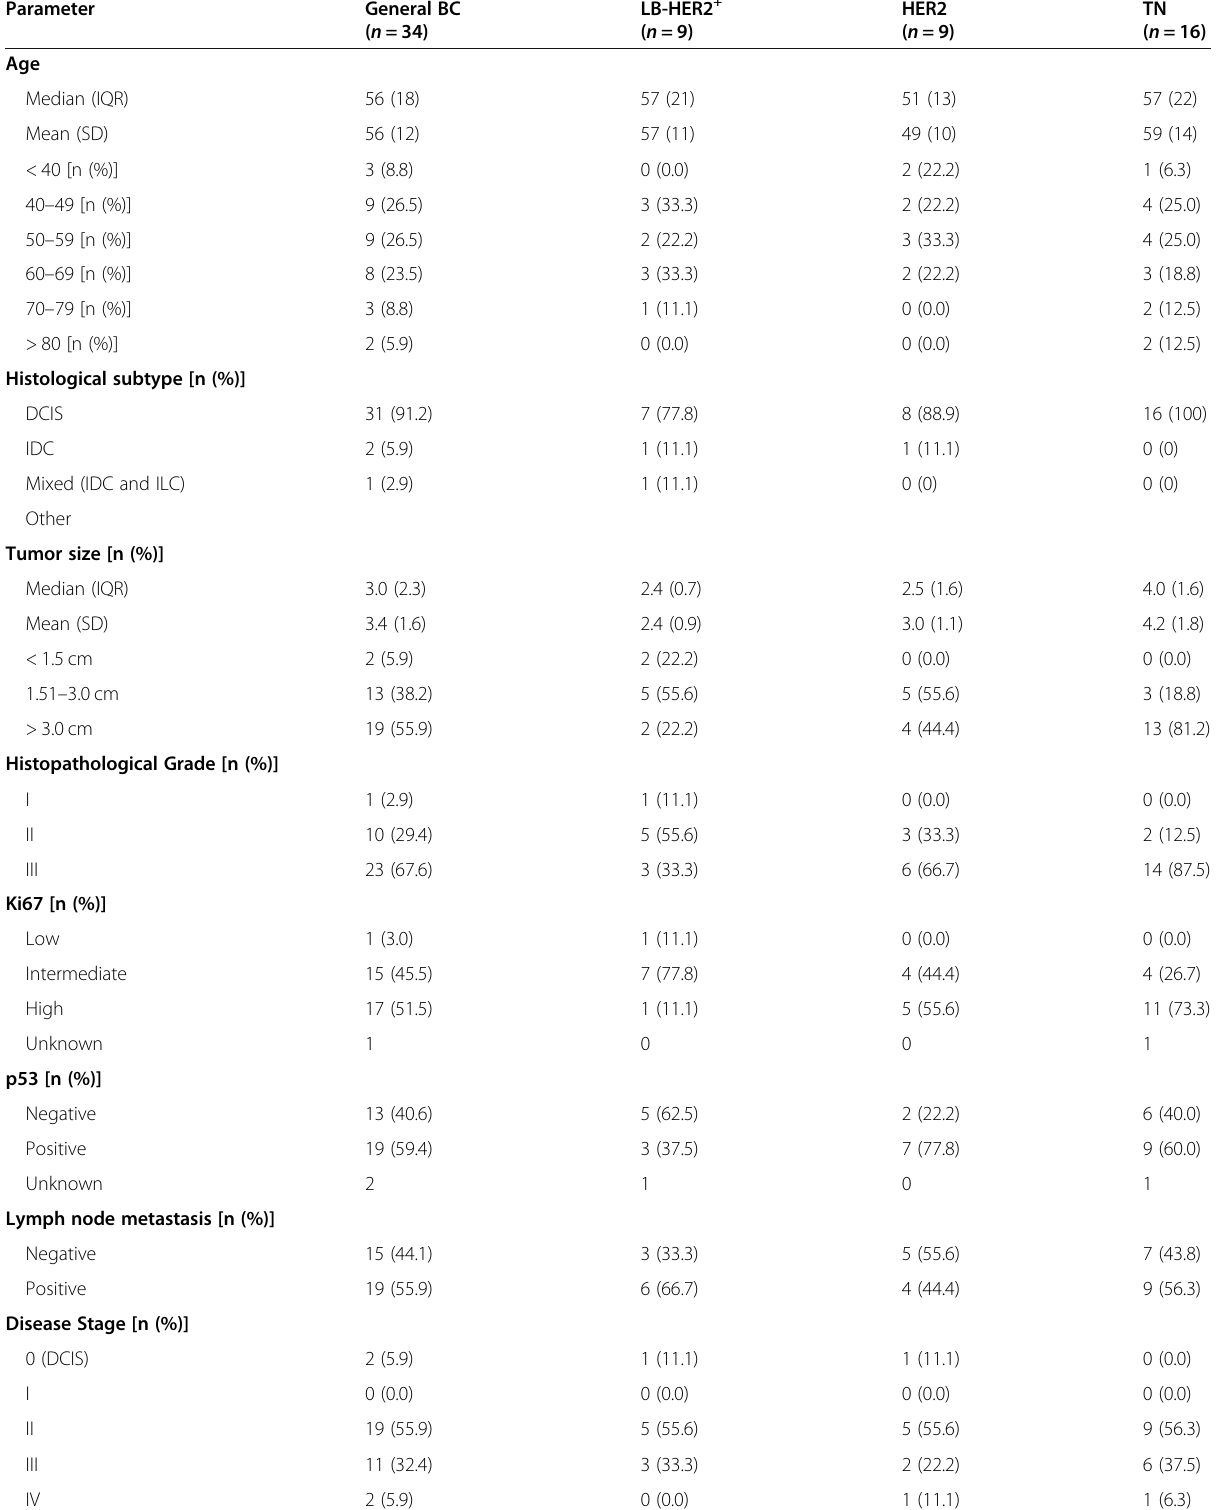
Table 1 Patients ’ clinicopathological